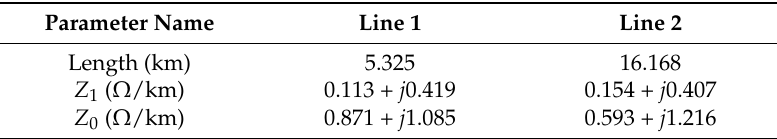
Table A2. The 110 kV transmission line parameters.